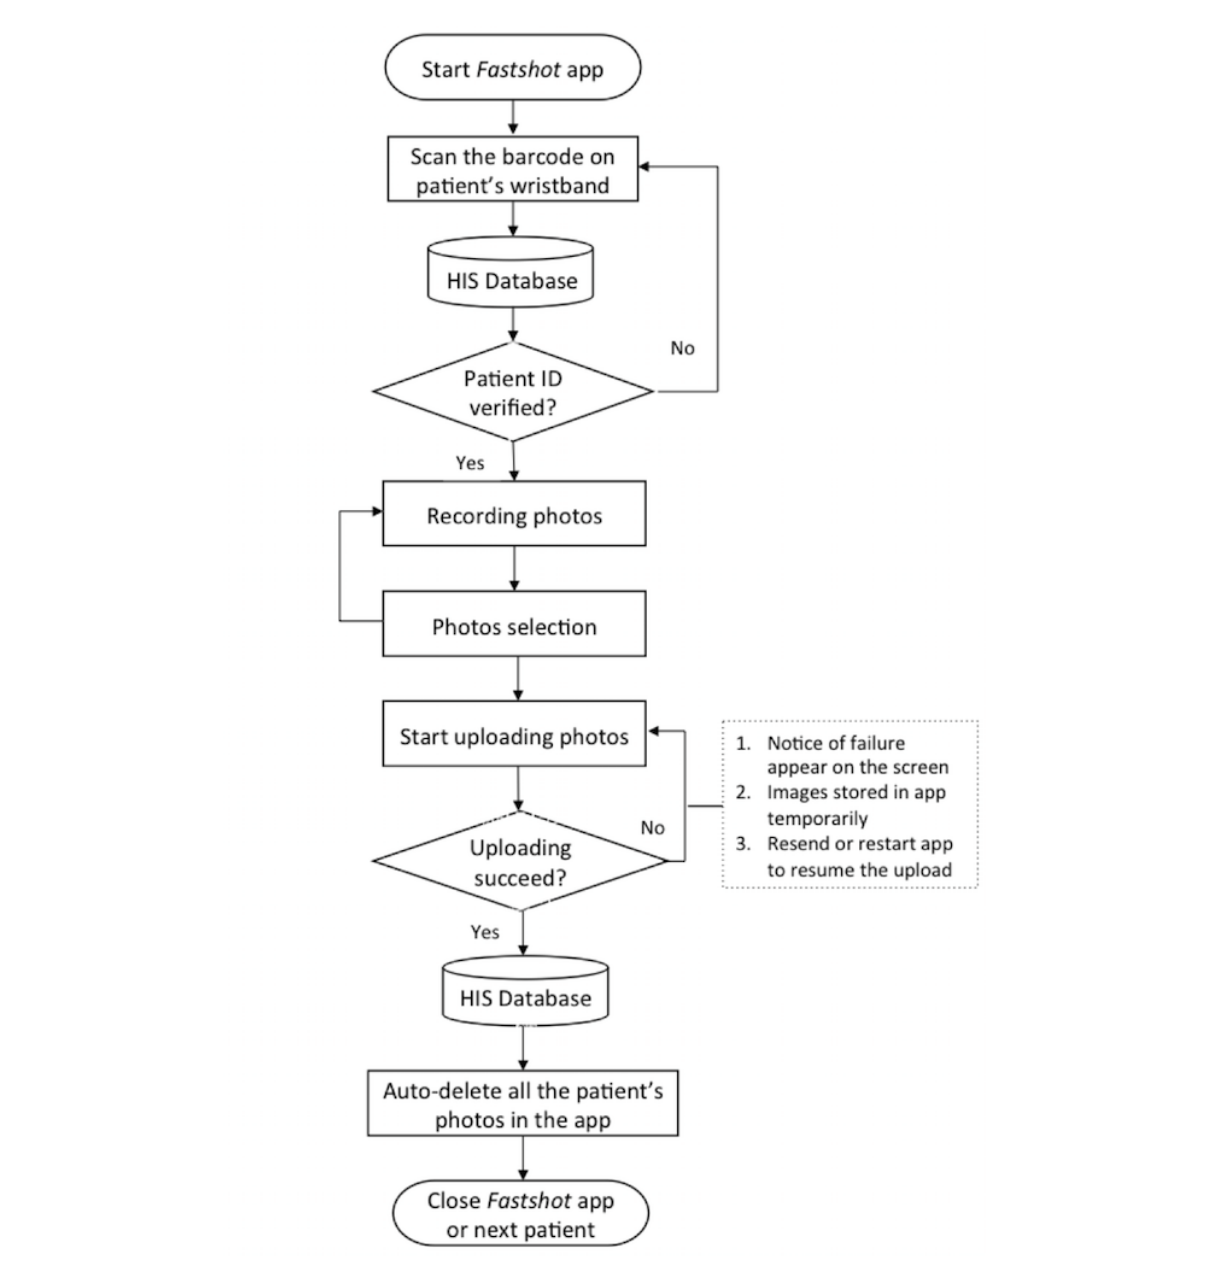
Figure 1. The workflow of the functional steps of the Fastshot app. HIS: hospital information system; ID: